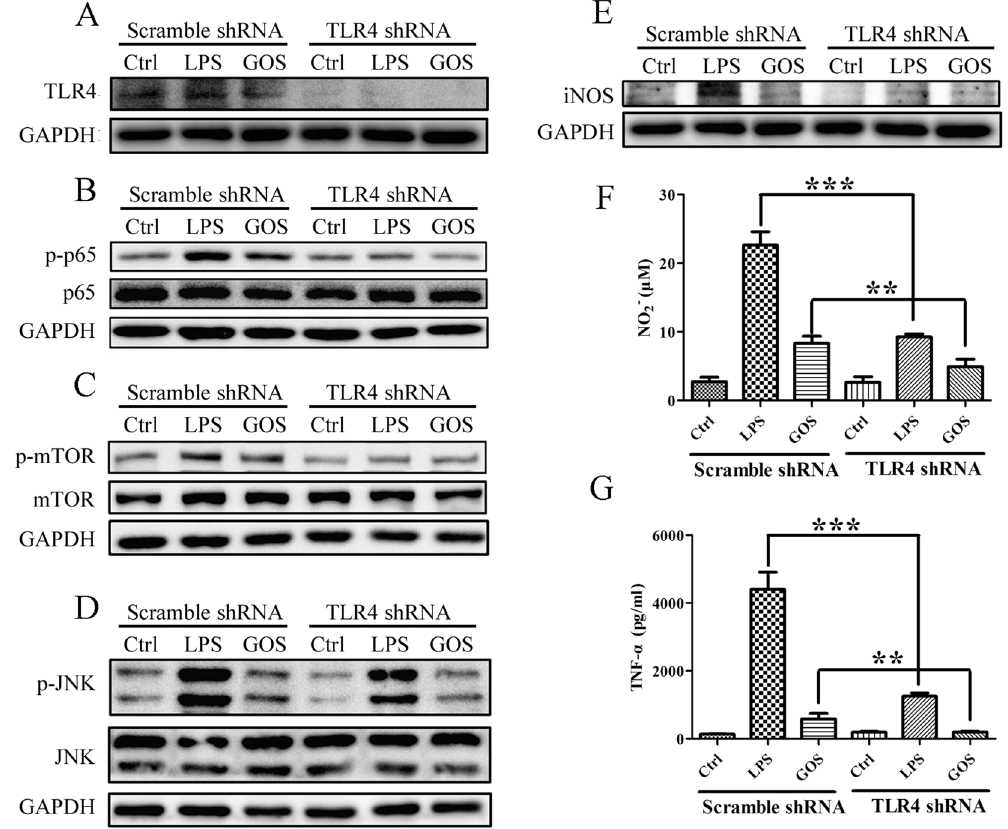
Figure 5. Knockdown of TLR4 with shRNA suppresses GOS-induced activation of signal transduction. ( A ) RAW264.7 cells were infected with lentivirus expressing either scramble shRNA or TLR4 shRNA. After treatment of LPS (1 μ g/ml) (as a positive control) or GOS (1 mg/ml), TLR4 protein expression was detected by Western blotting. ( B – D ) Phosphorylated and nonphosphorylated p65 ( B ), mTOR ( C ) and JNK ( D ) were detected by Western blotting. ( E ) iNOS protein expression was assessed by Western blotting. The full-length western blots were presented in supplementary information. ( F ) Nitrite production in the culture supernatant of treated infected cells was measured by the Griess assay. ( G ) TNF- α in the culture supernatant of treated infected cells was measured by ELISA. Representative images and results from three independent experiments are shown, ** P < 0.01, *** P <